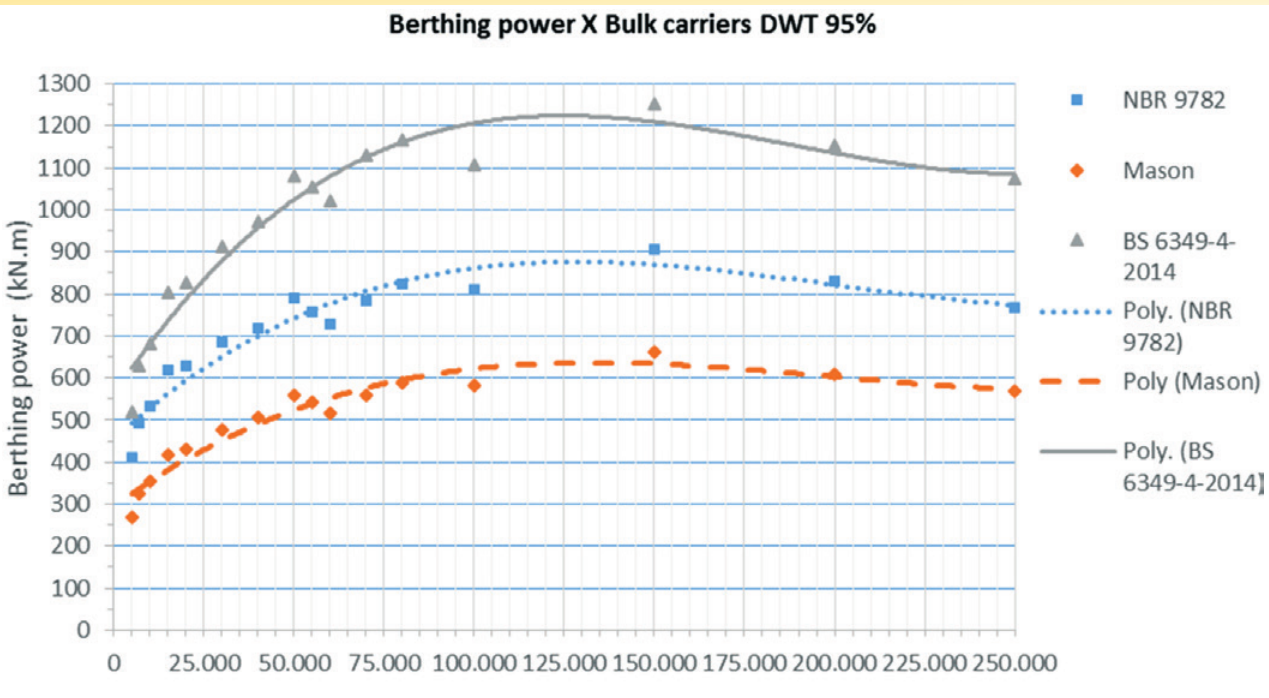
Figure 18 Rated Berthing Force X Ship’s